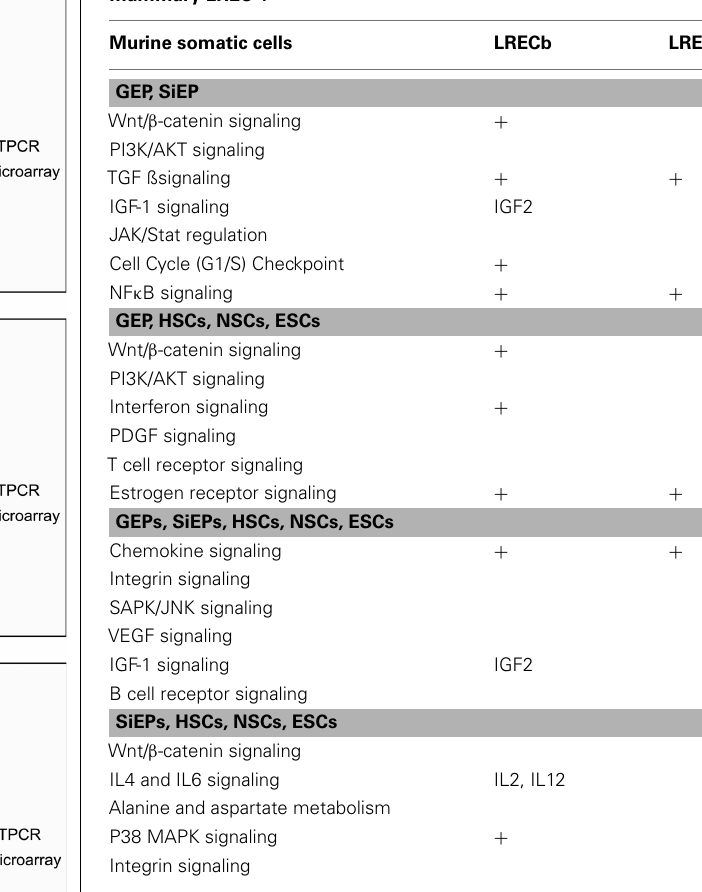
Table 4 |Attributes of murine somatic stem cells and bovine mammary LREC 1